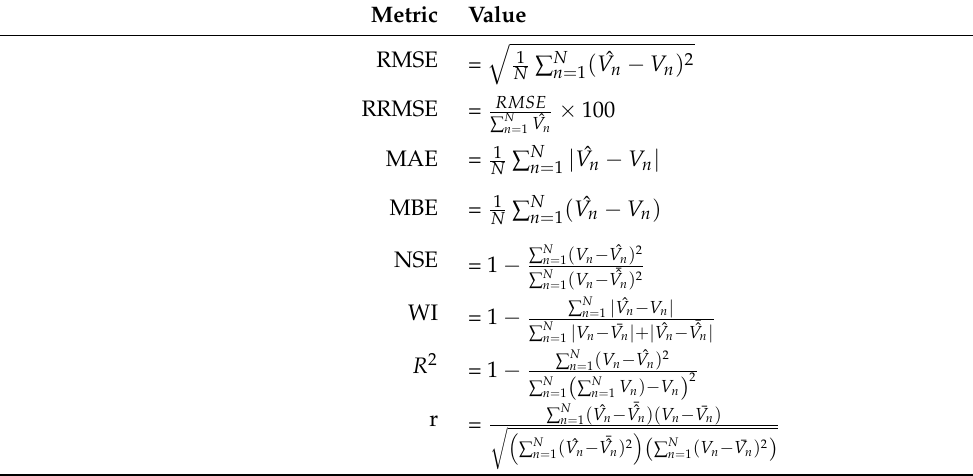
Table 3. List of metrics used in performance evaluation.